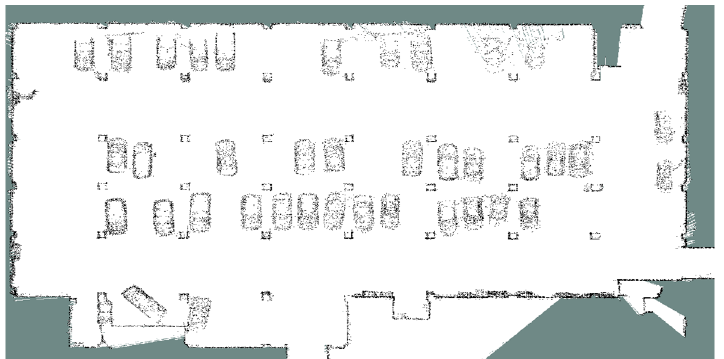
Figure 14. Construction of 2D occupancy grid map for the underground parking lot scene.